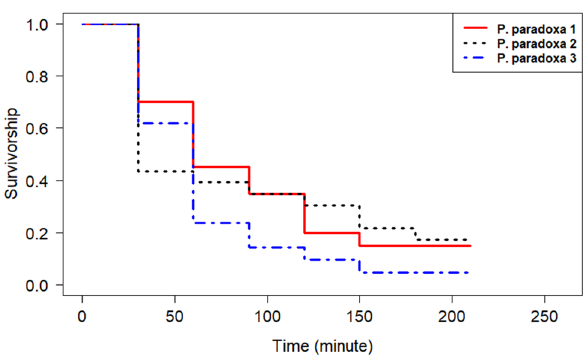
Figure 1. Dynamics of Phyllocrania paradoxa predation on Aedes aegypti